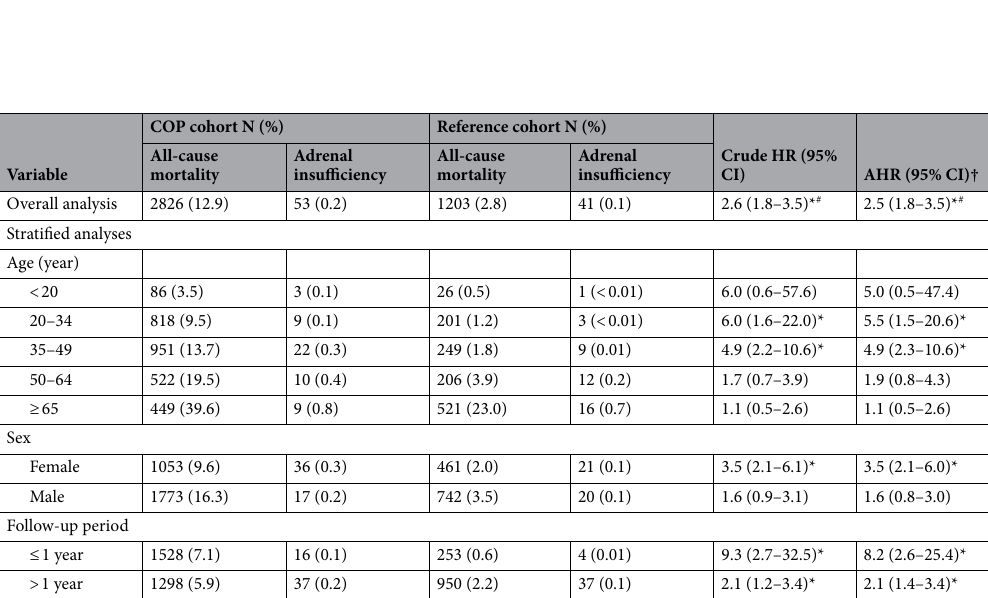
Table 2. Comparison of the risk for adrenal insufficiency during whole the follow-up period between the COP and references cohorts using competing risk survival analyses. COP carbon monoxide poisoning; HR hazard ratio; AHR adjusted hazard ratio; CI confidence interval. * p < 0.05. †Adjusted for sex, underlying comorbidities including liver disease, thyroid disease, and mental disorder. # Coxregression model with robust sandwich